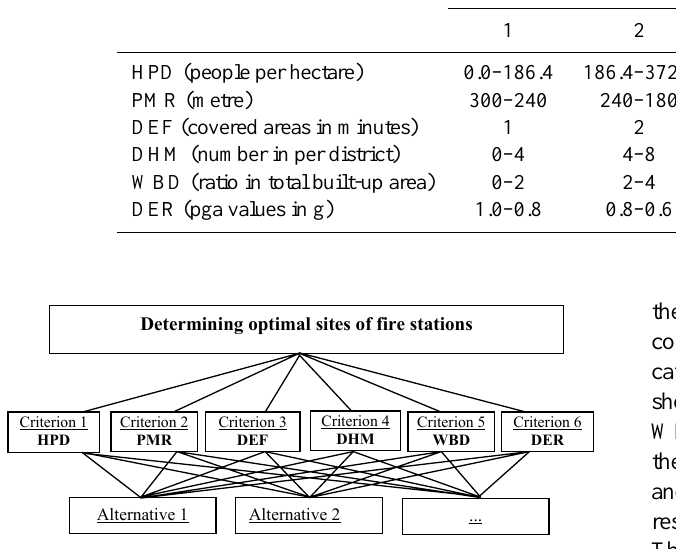
Figure 3. Representation of the 3-level structure of objective, criteria and alternatives Fig. 3. Representation of the 3-level structure of objective, criteria and